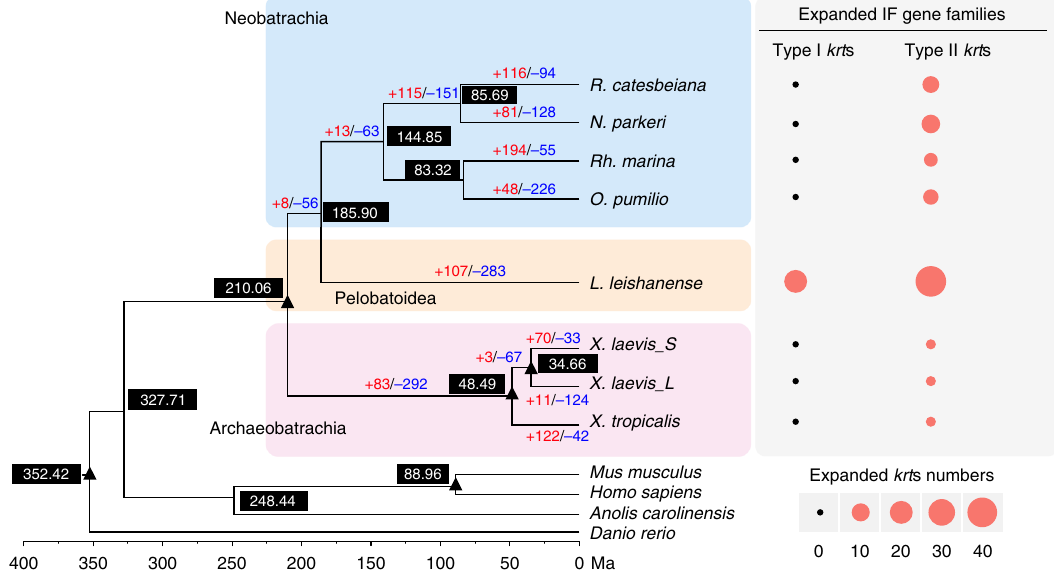
Fig. 2 Comparative genomic analyses across anurans. Values in black boxes are divergence times in units of million years ago (Ma, see “ Methods ” ). The number near each branch indicates the number of signi fi cantly expanded (red) and contracted (blue) gene families for each clade. Nodes marked with black triangles are used as time calibration nodes. Two intermediate fi lament (IF) gene families were detected under signi fi cant expansion, which include type I and type II keratin genes, respectively. The numbers of expanded keratin genes in different anurans compared to their most recent common ancestor are displayed in circle